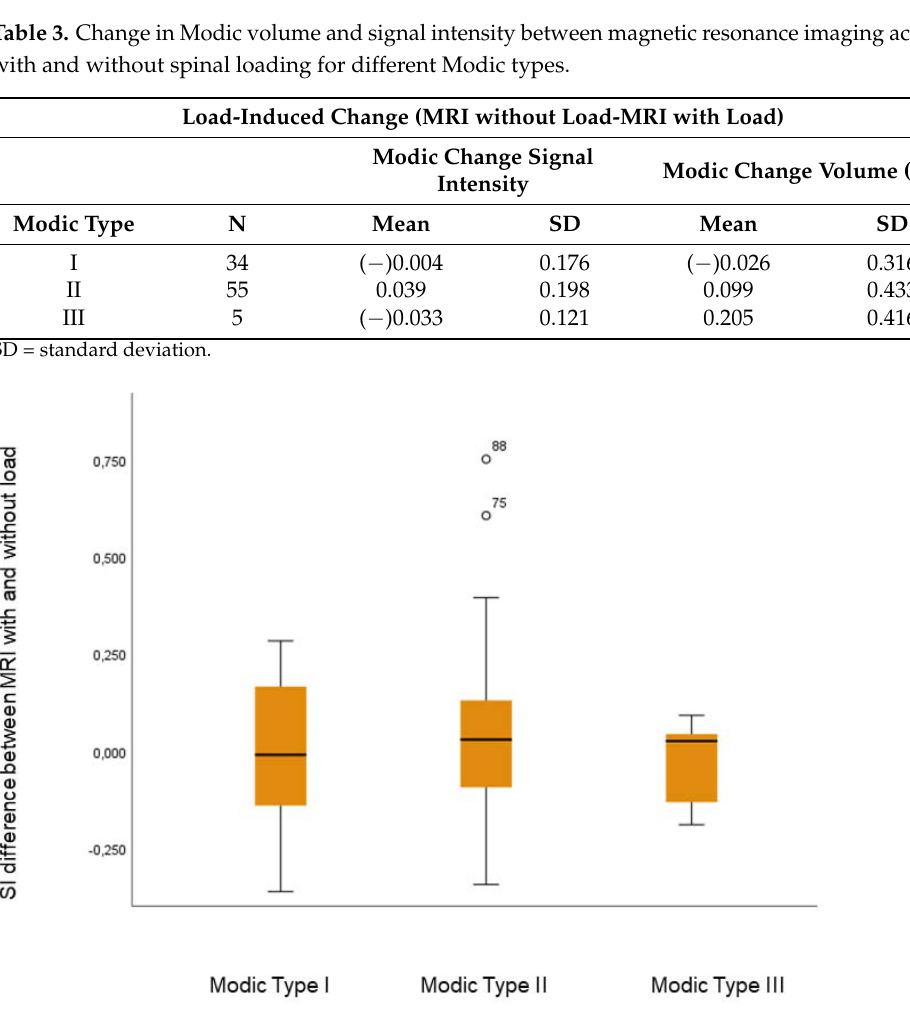
Figure 3. Box plot of signal intensity (SI) change between MRIs with and without load in Type I ‐ III Modic lesions